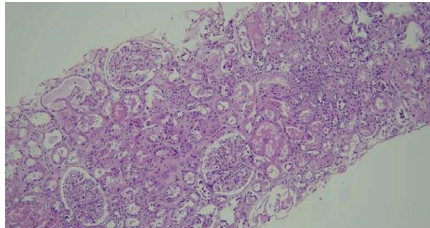
Figure 2: Slight enlargement of the glomerular tufts of hema- toxylin cosine × 100 and slight thickening of the basement mem- brane are observed.